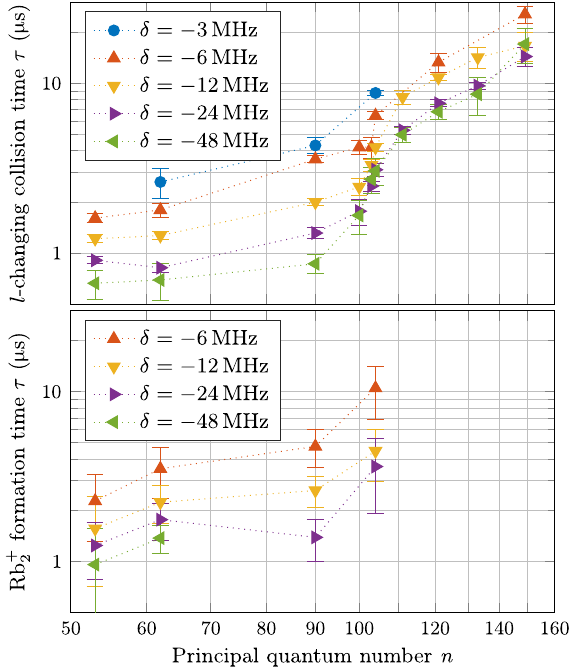
FIG. 8. Extracted inelastic collision times for the l -changing collision (top panel) and the formation of Rb þ 2 (bottom panel). the measured signal of the reaction products I ð t Þ by fitting I ð t Þ ∝ 1 − exp ð − t= τ Þ with the error bars, indicating the confidence interval of the fit taking into account multiple measurements at each data point. Unexpectedly, at around a principal quantum number of 90 < n < 110 , a threshold is reached, leading to significantly higher lifetimes of the Rydberg state at higher principal quantum numbers independent of laser detuning and thus the density. The Rb þ 2 formation time could not be measured for high n because the total number of molecules measured was too low at these principal quantum